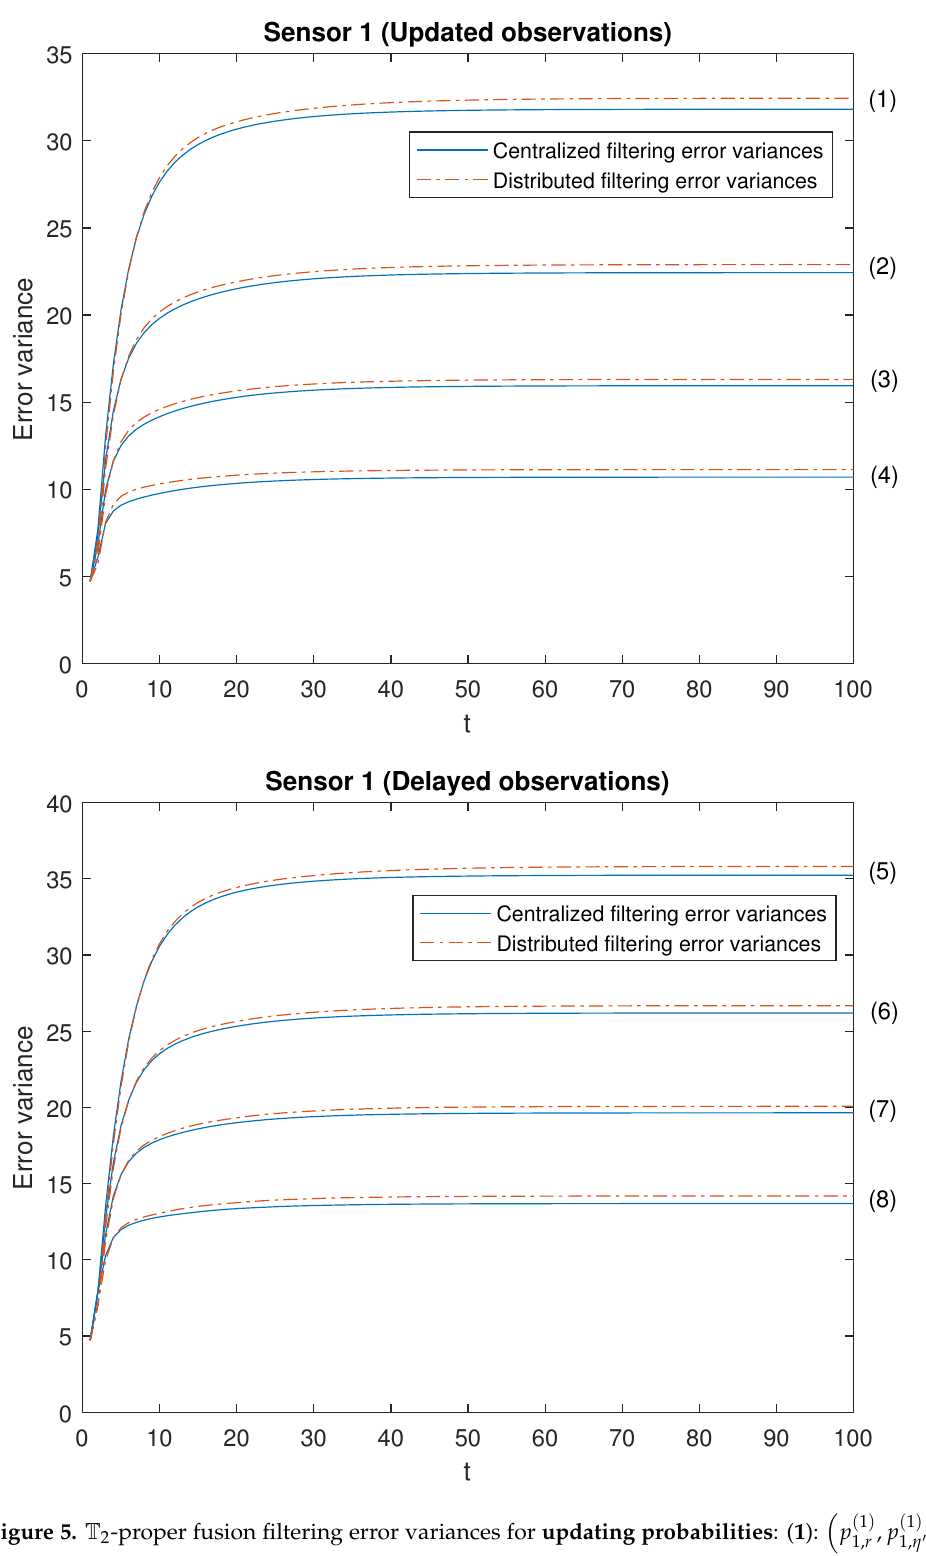
Figure 5. T 2 -proper fusion filtering error variances for updating probabilities : ( 1 ): ( 0.3,0.2 ) ; ( 2 ): delay probabilities : ( 5 ): ( 0.7,0.6 ) ; ( 8 ):